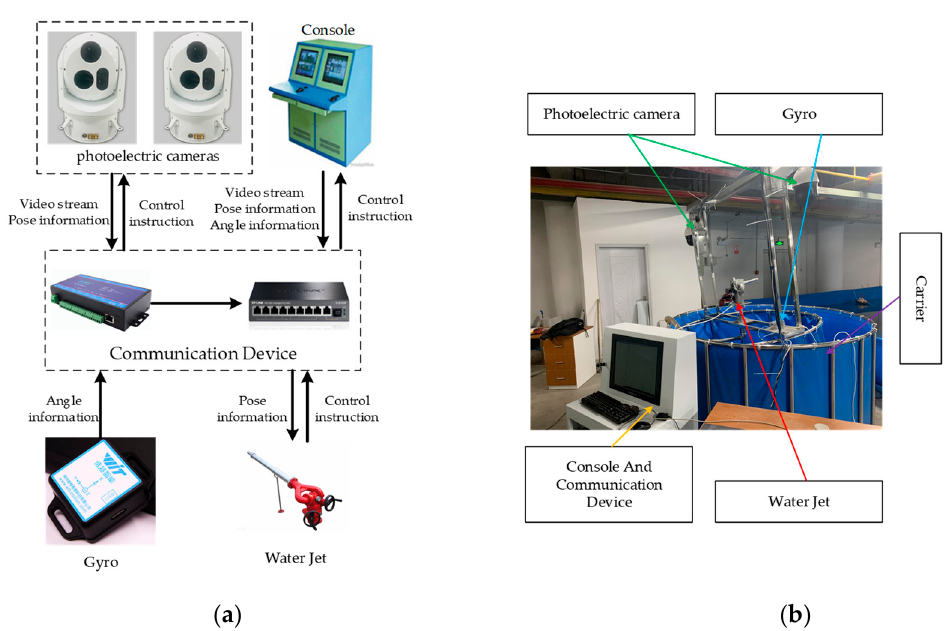
Figure 1. System hardware and physical platform. ( a ) Hardware module diagram; ( b ) Picture of the physical platform.